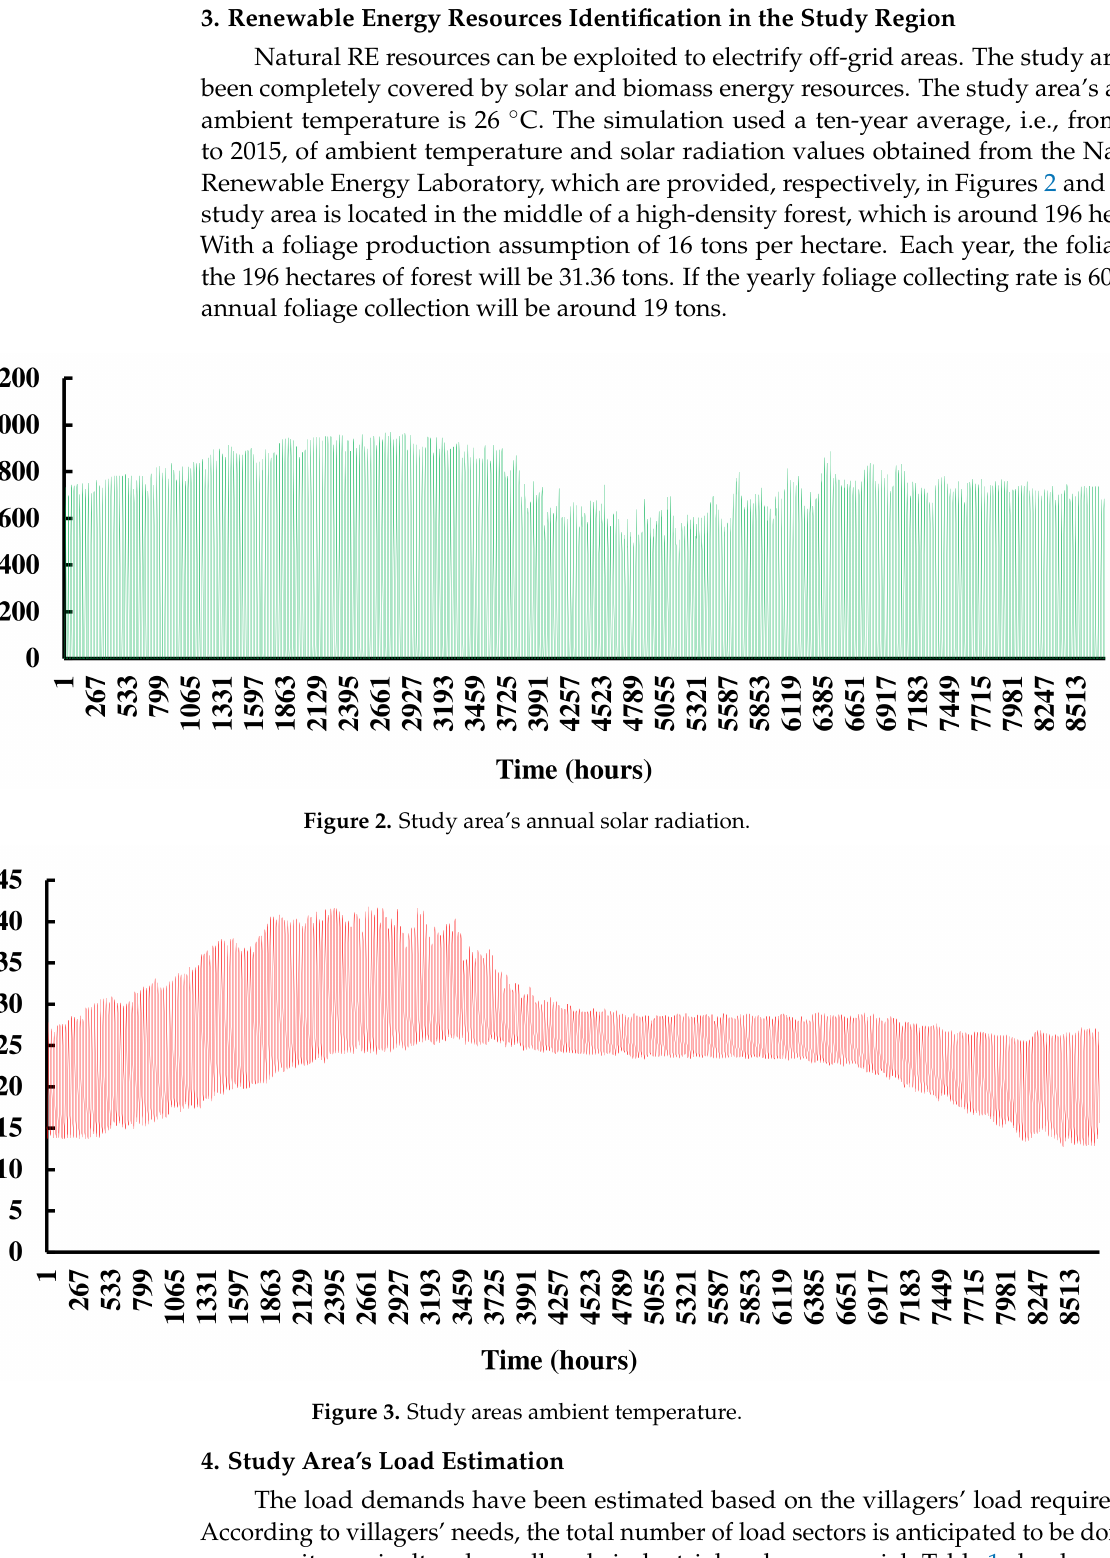
Figure 3. Study areas ambient